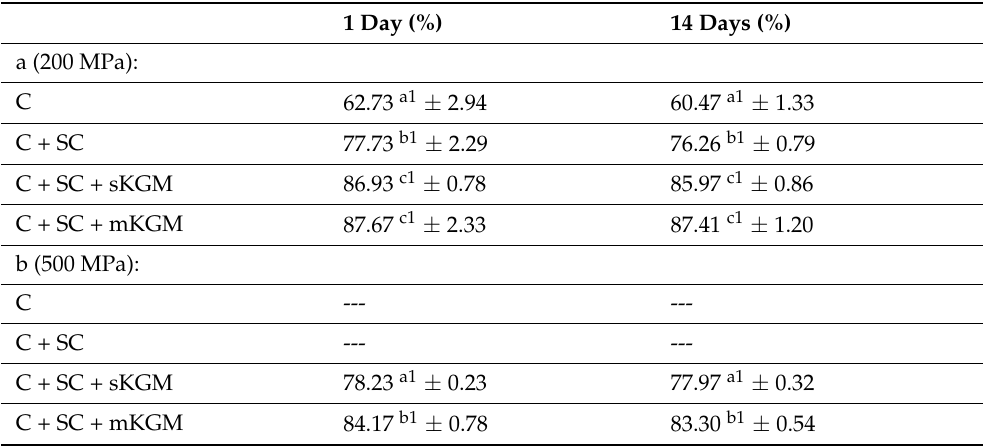
Table 3. WBC (water binding capacity) of myosin gels after 1 and 14 days of chilled storage. 1 Day (%) 14 Days